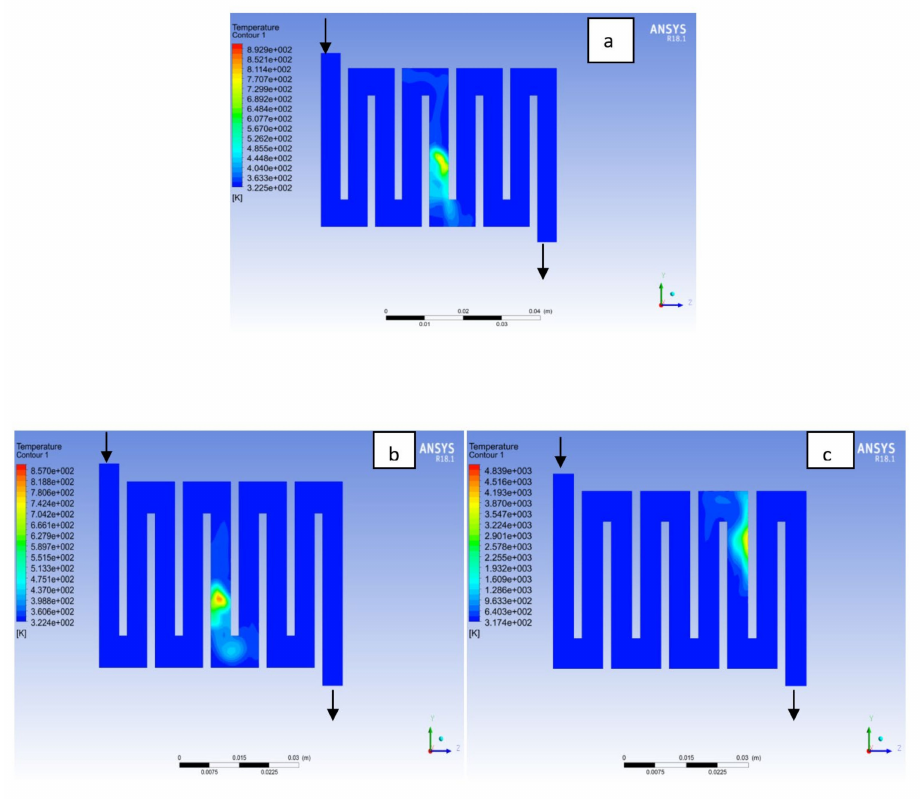
Figure 6. Temperature distribution at the anode region (GDL/CL) for each material at 323K: ( a ) Aluminum, ( b ) Copper, ( c )